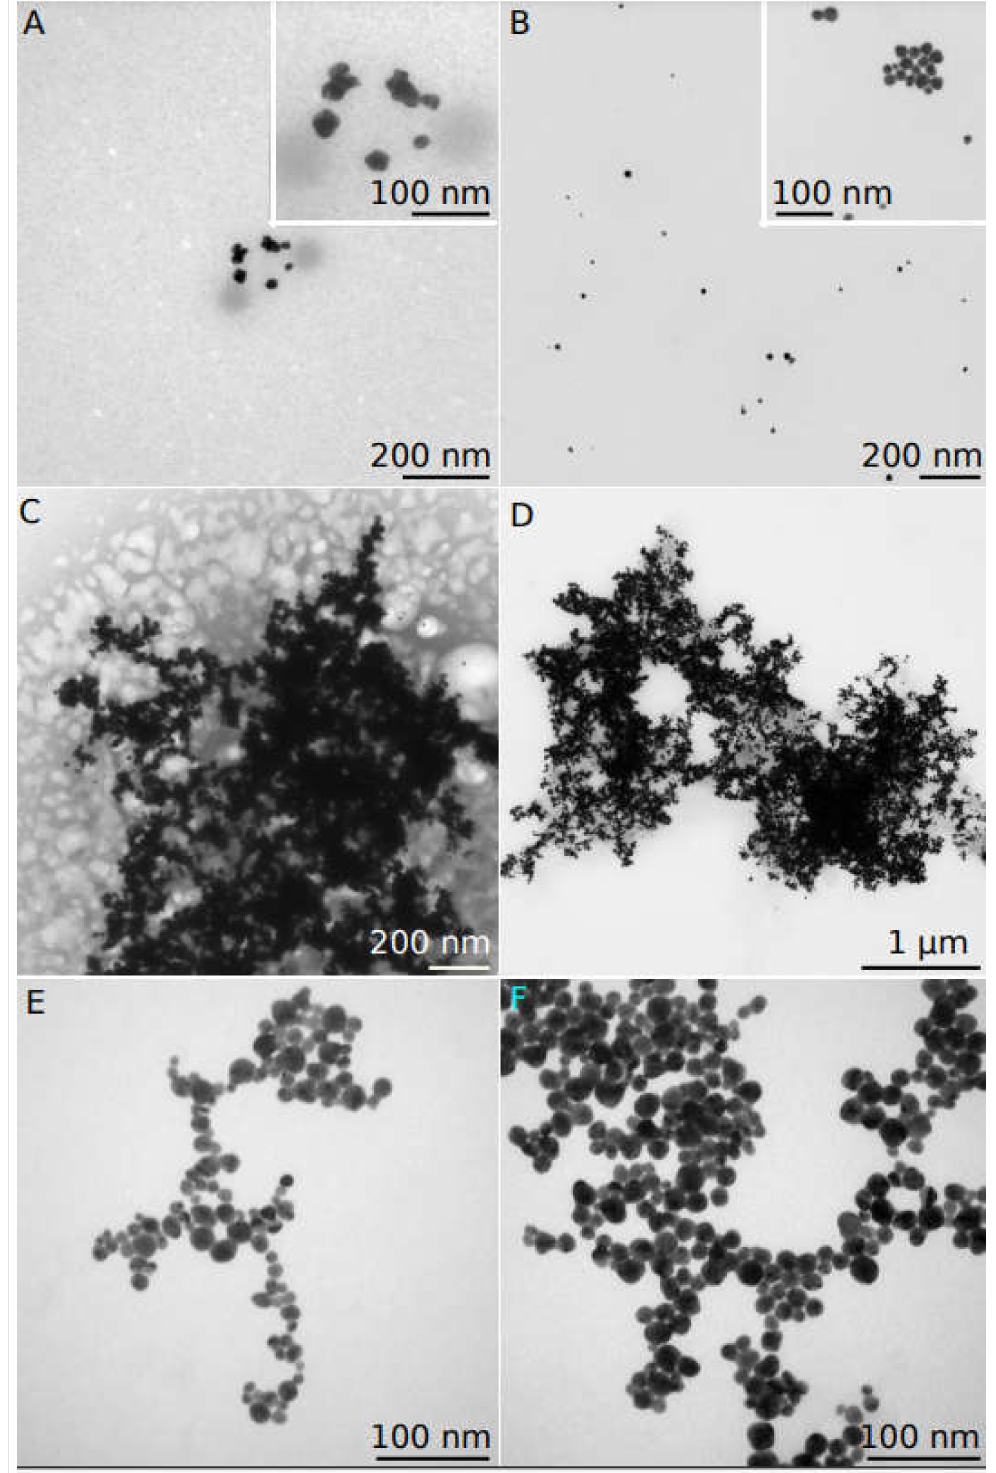
Figure 4. TEM images obtained from different samples: ( A ) unwashed sample at pH 2; ( B ) washed sample at pH 6; ( C , D ) washed sample at pH 2; ( E , F ) washed sample at pH 10. Scale bars: ( A ) = 200 nm; ( B ) = 200 nm; ( C ) = 200 nm; ( D ) = 1 µ m; ( E , F ) = 100 nm; the inserts in ( A , B ) = 100